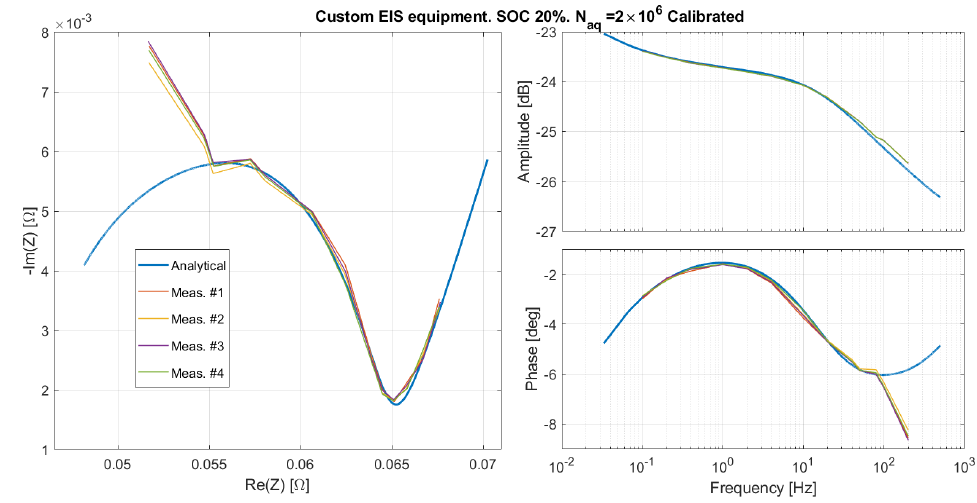
Figure 12. The emulated impedance as measured by the custom EIS measurement system after the calibration illustrated in Section 5.1.